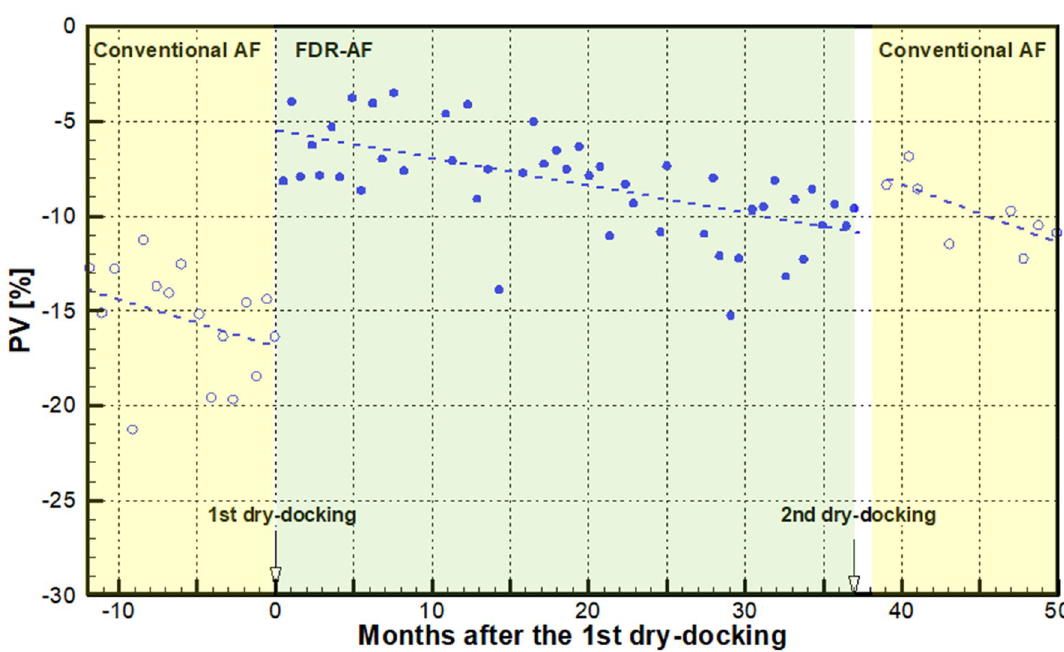
Figure 7. Temporal variation in the voyage-averaged